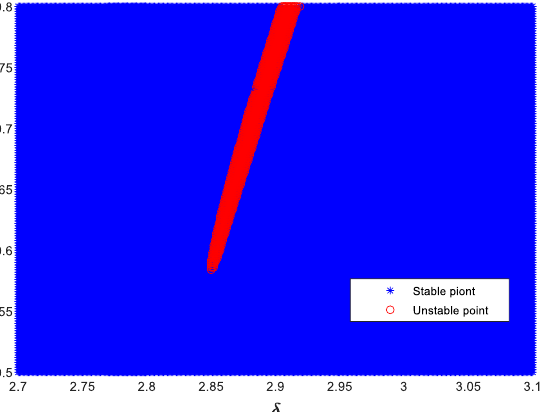
Figure 18. Local chart of the 6T- resonance line: x + 2 ξ x + ( δ + 2 ε cos2 t ) x + KD P [ x ] = F cos ( t /3 ) . Next, the effects of linear damping and fractional‑order parameters on resonance lines were analyzed. The basic parameters of Equation (4) were selected as F = 1, w i = 1, K = 0.005, and p = 0.5, and the linear damping was selected as 0, 0.001, and 0.005, respectively. The 6T ‑resonance line is shown in Figure 19. As can be seen from Figure 19, the resonance line gradually shrank upward and narrowed in width as the damping increased. Therefore, the damping changed the position of the resonance line, and the increase in damping not only reduced the influence of forced excitation, but also enlarged the range of the system stability region.